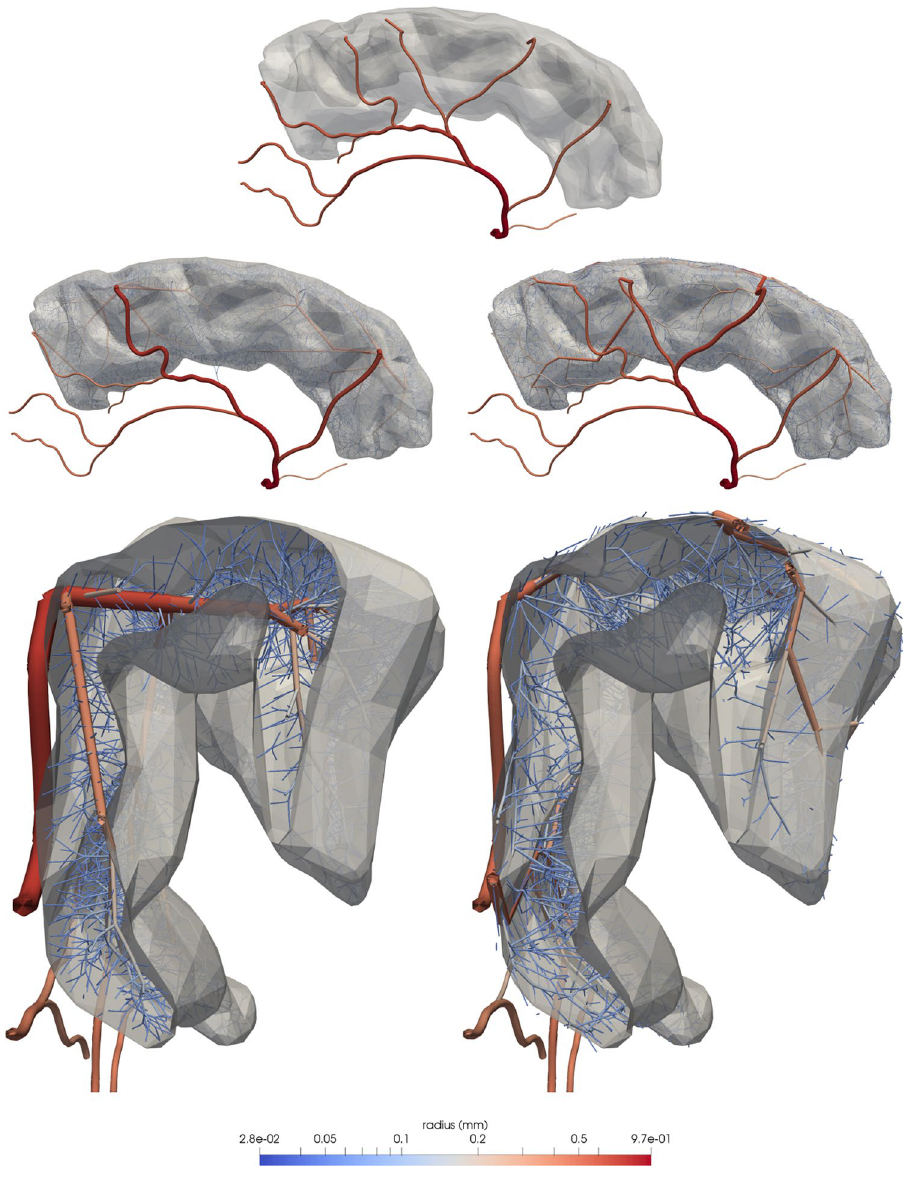
Figure 10. Comparison between standard CCO (left column) and the proposed DCCO (right column) methods. (Top) Initial vasculature; (middle) generated trees of 8000 terminal segments; (bottom) coronal slices at a middle section of the rostral-caudal axis. Images generated with ParaView version 5.4 available at https :// www.parav